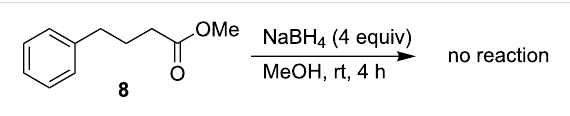
Table 3: Comparative study a on reduction of various oxo-groups.